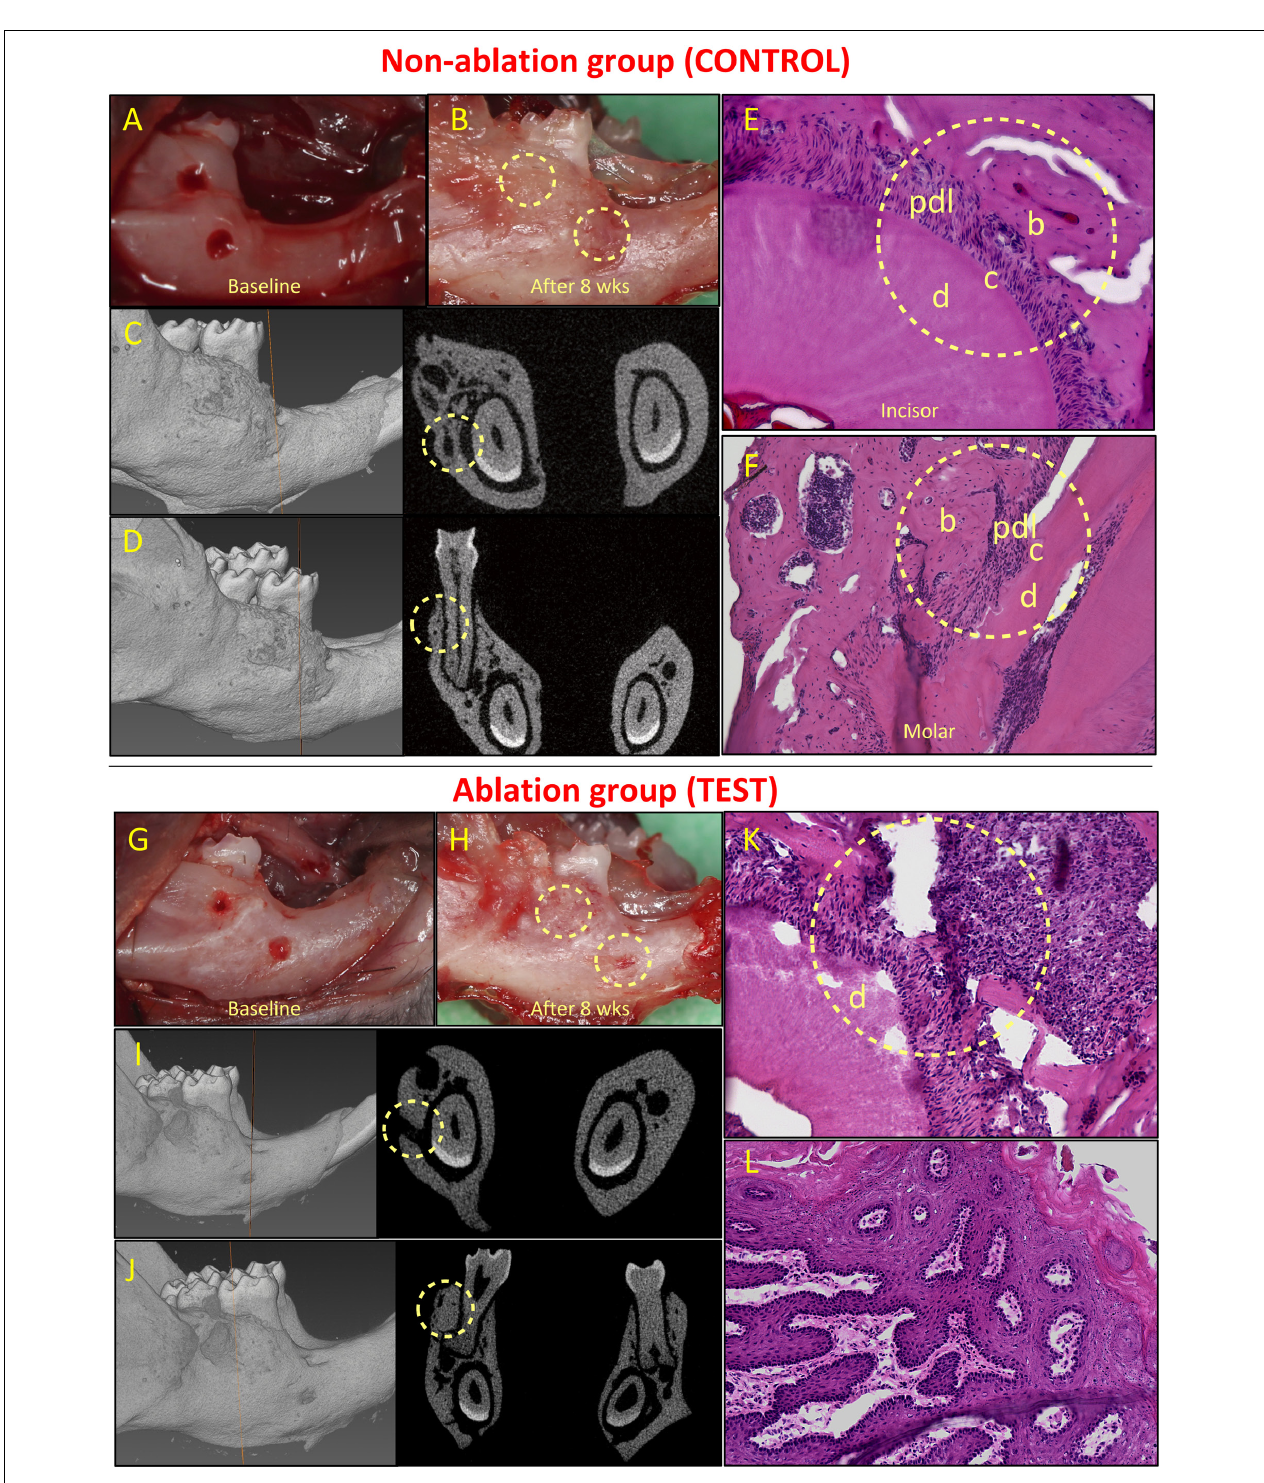
FIGURE 4 | Healing of non-critical defects in non-ablation (images above the red line; A–F) and ablation (images below the red line; G–L) groups ( n = 5). Two defects were created around the mandibular incisor and first molar teeth in both groups (A and G) . In the non-ablation group, healing of both defects was observed clinically for all animals (B) . Micro-CT analysis confirmed the healing of incisor (C) and molar (D) defects, and histological analysis confirmed regeneration of the periodontal incisor (E) and molar (F) defects. In the ablation group, lack of healing was observed for incisor defects in all animals (H) . Micro-CT (I) and histological (K) analyses confirmed lack of periodontal regeneration for incisor defects in this group. The molar defects were mainly healed by excessive and irregular bone formation (H, J, L) . b, bone; c, cementum; d, dentine; and pdl, periodontal ligament.